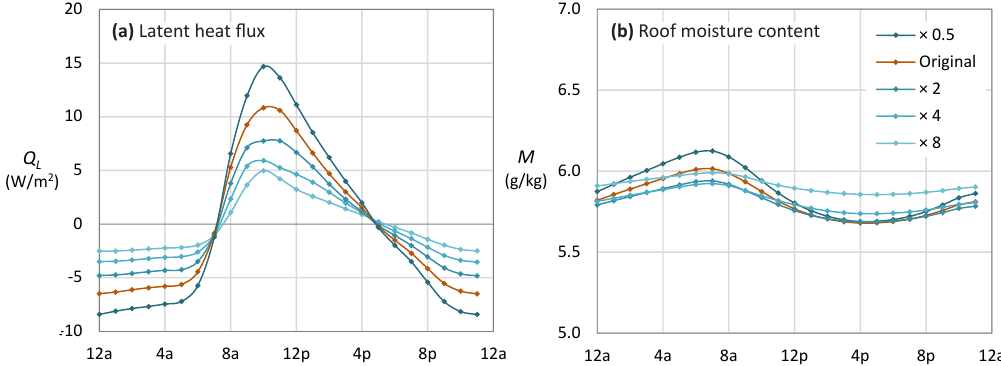
Figure 18. Effect of varying the vapor diffusion resistance factor µ (Figure 17) on ( a ) latent heat flux Q L and ( b ) moisture content M in Apulian limestone, illustrating the marked effect of µ on Q L , but relative lack of consequence for M . Data show average hourly July values in the humid subtropical climate of Gioia del Colle, Italy (Köppen Cfa , Table 3; Figure 9) for the south-facing panels of beehive-shaped roofs; the Original is the fine-grained Apulian limestone of Andriani and Walsh [55]. Ambient humidity was the only source of